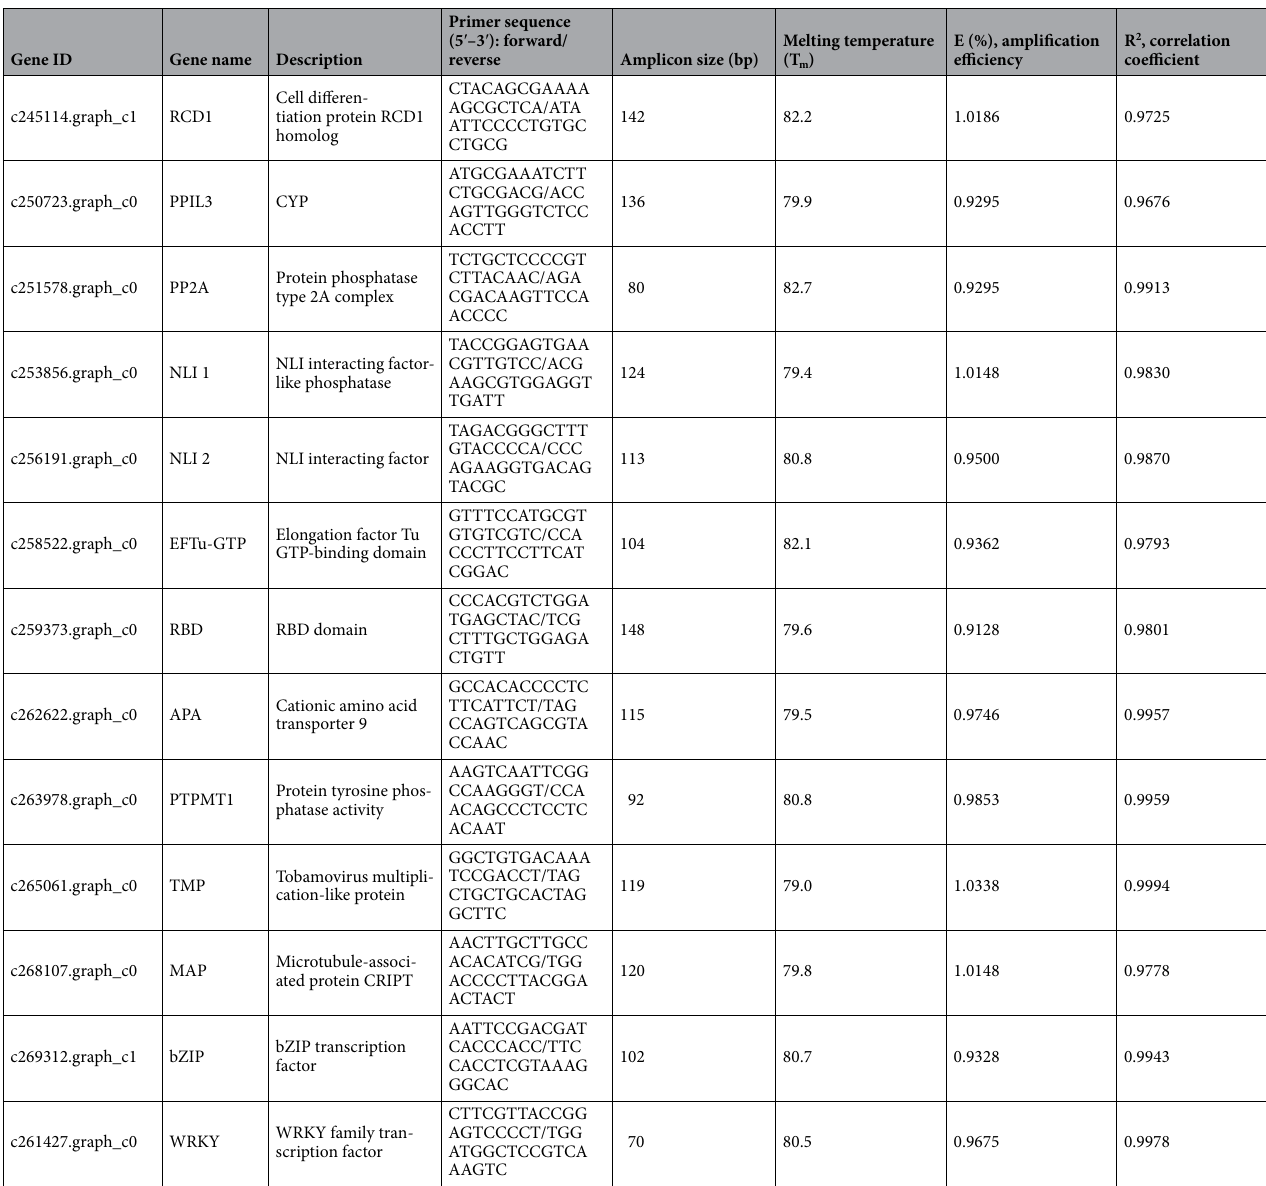
Table 1. Caucasian clover candidate reference genes, primer sequences, amplicon sizes, melting temperatures